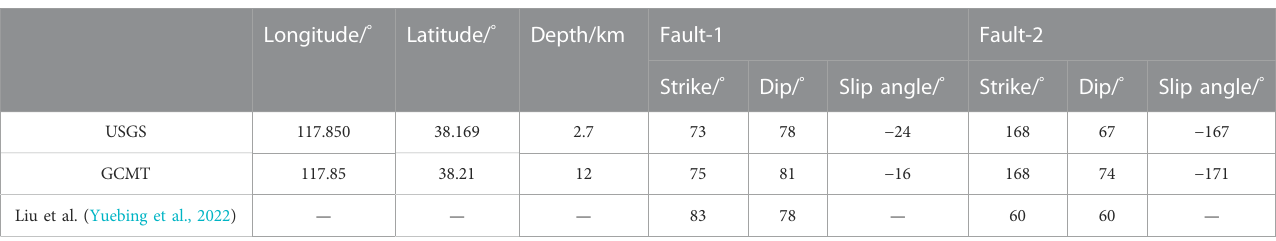
TABLE 4 Focal mechanism solution of the Nevada earthquake.